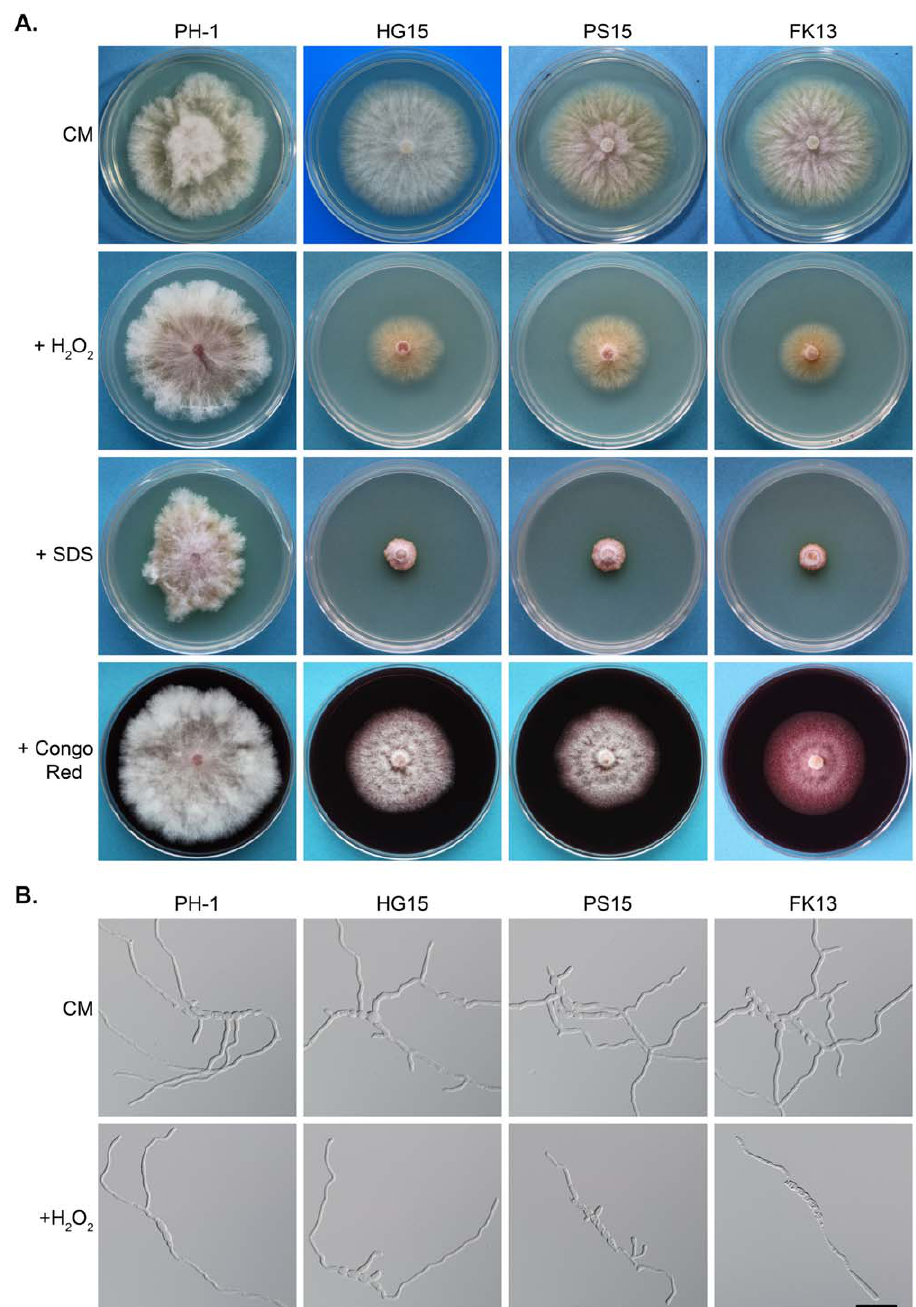
Figure 3. The FgHog1 MAPK pathway also is involved in responses to oxidative, cytoplasm membrane, and cell wall stresses. A . Colonies of PH-1 and the Fghog1 (HG15), Fgpbs2 (PS15), and Fgssk2 (FK13) mutants on media with 0.05% H 2 O 2 , SDS, and Congo red. B . Germ tubes of the Fghog1 , Fgpbs2 , and Fgssk2 mutants incubated in liquid YEPD with 0.005% H 2 O 2 . Bar=40 m m.